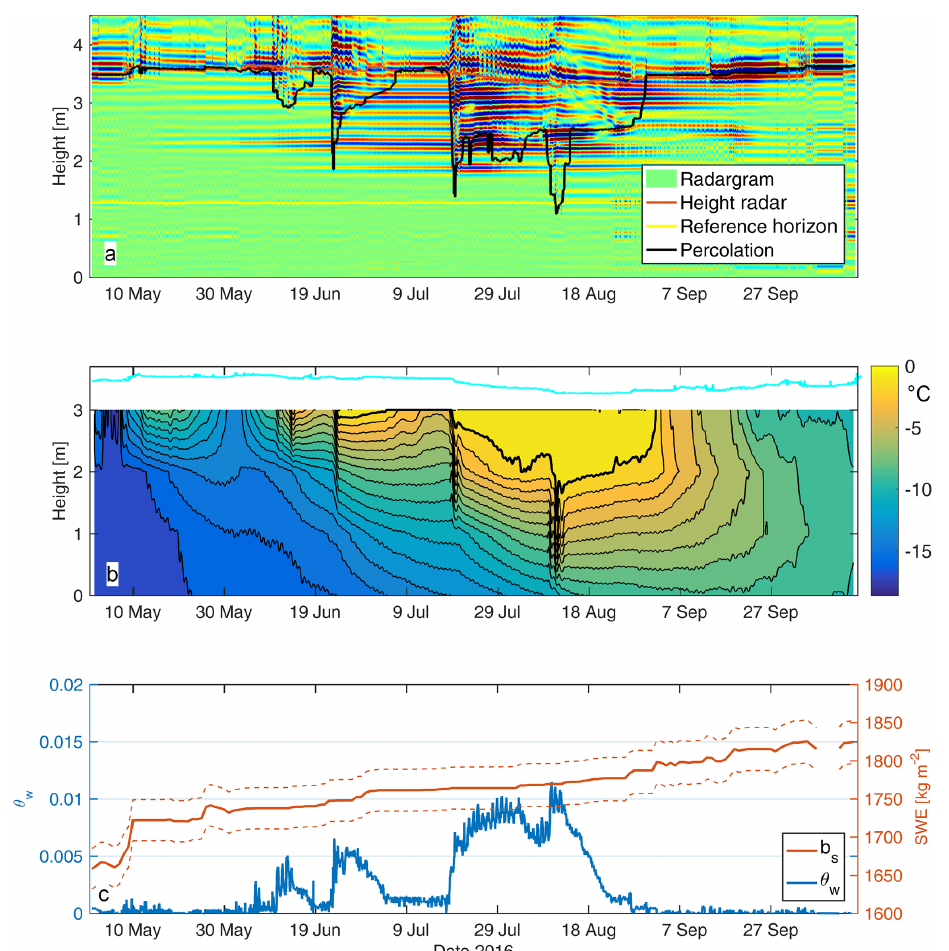
Figure 5. (a) Radargram of the observed six month time period in 2016 with display of water percolation. (b) Recorded and interpolated snow and firn temperatures with 1 ◦ C contour interval for the upper four thermistors of the installed thermistor chain. The bold contour line displays the − 1 ◦ C isotherm. The cyan line in (b) represents the snow surface measured by the FirnCover ultrasonic transducer. (c) Derived bulk volumetric liquid water contents above the antennas (blue line, left axis) in comparison to radar data of changes in total mass in snow water equivalent (SWE) for the same layer (brown line, right axis). The dashed lines in (c) represent the uncertainty of SWE arising from the error in density and layer thickness determinations.